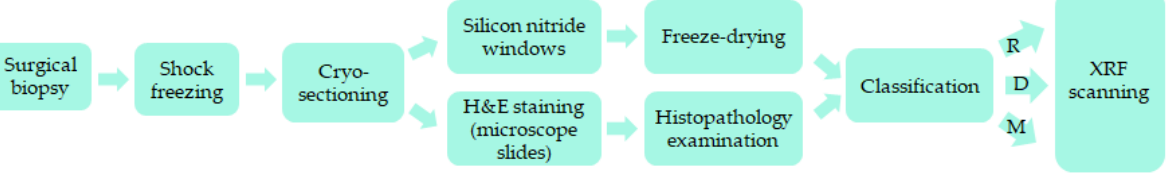
Figure 5. Schematic of the tissue sample preparation protocol. Abbreviations: D—dystrophies group; M—myopathy group; R—reference group.